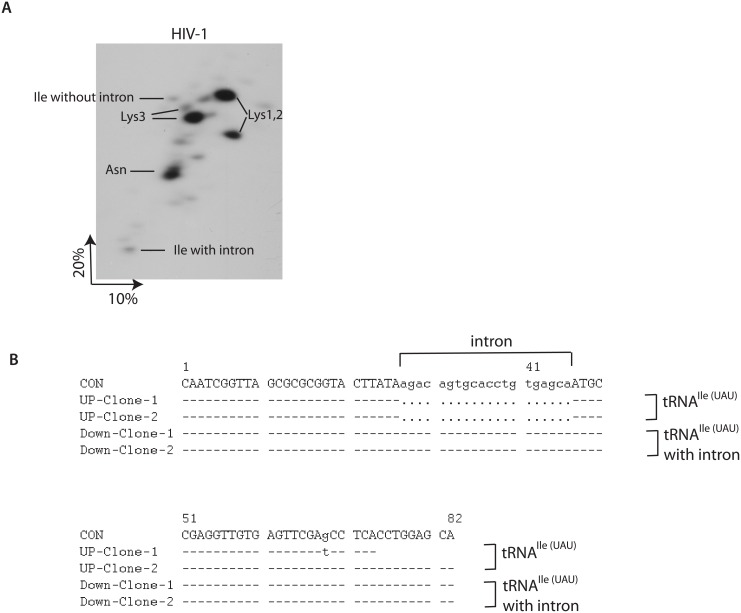
Two dimensional polyacrylamide gel electrophoresis (2D-PAGE) analysis of low molecular weight RNA from HIV-1.(A) 2D-PAGE pattern. tRNALys3, tRNALys1,2, tRNAAsn are indicated. tRNAIle(UAU) with and without intron newly identified by RT-PCR and sequencing are also indicated. Sequences of two clones are listed in panel B. (B) Sequence alignment of tRNAIle(UAU). Con represents the consensus of tRNAIle(UAU). The intron sequences are in small letters. Dash “-” stands for the same sequence as the consensus. Dot “.” stands for the sequence deletion.